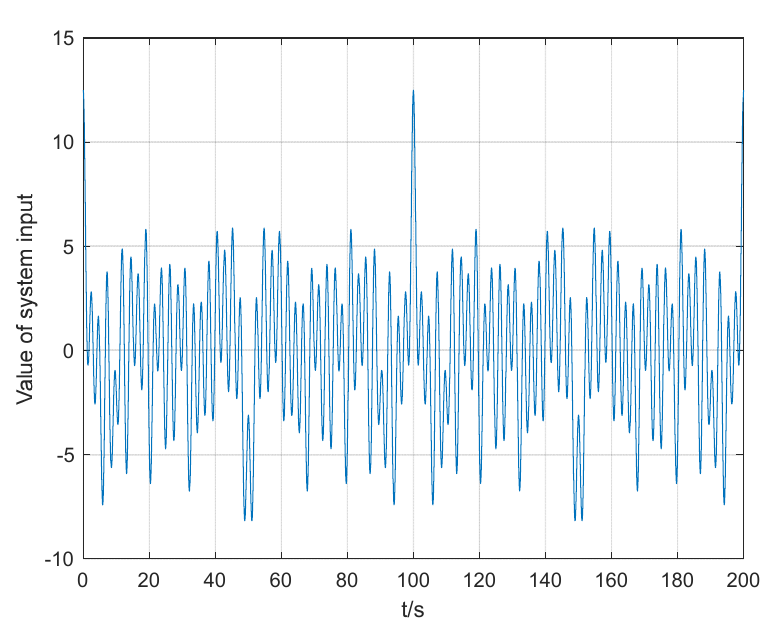
( b ) Figure 2. ( a ) The theoretical value and calculated value of 𝐶 (cid:2869)(cid:2869)(cid:3036) ; ( b ) the theoretical value and calculated value of 𝐶 (cid:2870)(cid:2869)(cid:3036) .